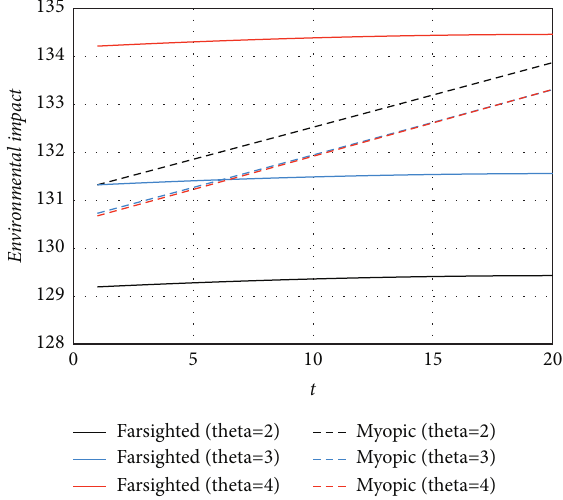
Figure 8: Impact of carbon sensitivity coefficient on